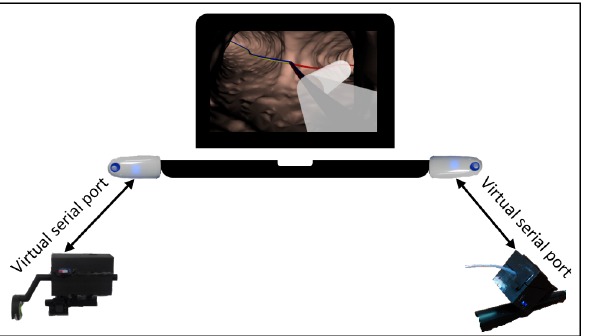
Figure 2. Communication between Devices D1 (on the right), D2 and D3 (on the left) and the virtual bronchoscopy visualization system.